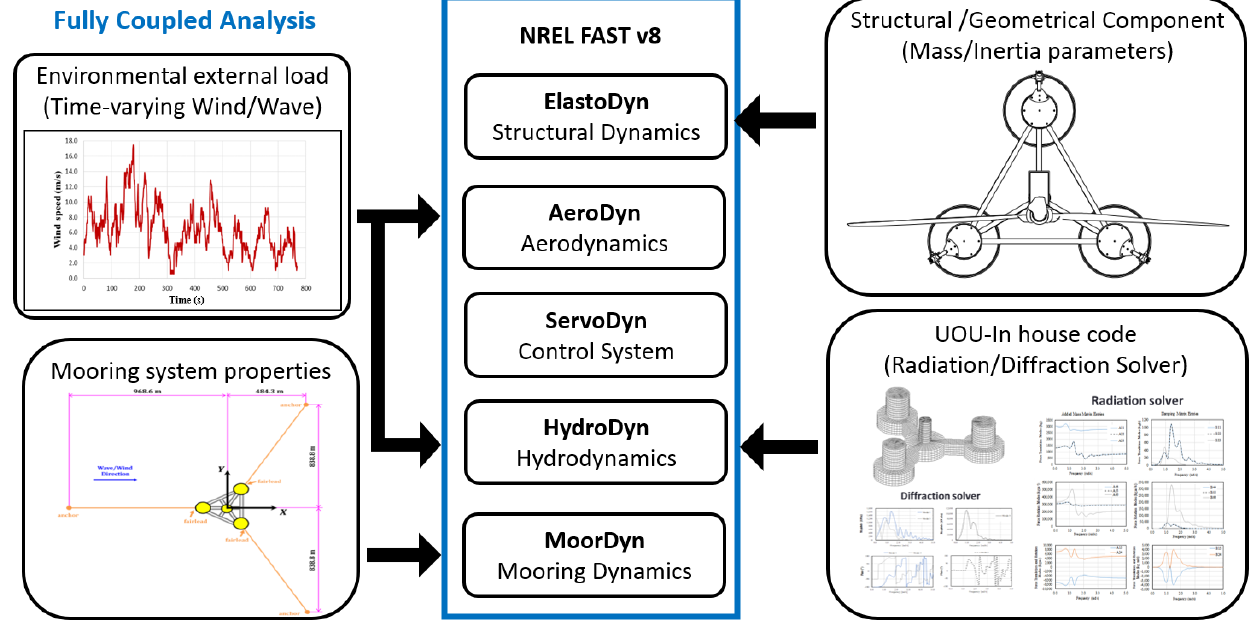
Figure 6. FAST simulation flow chart.